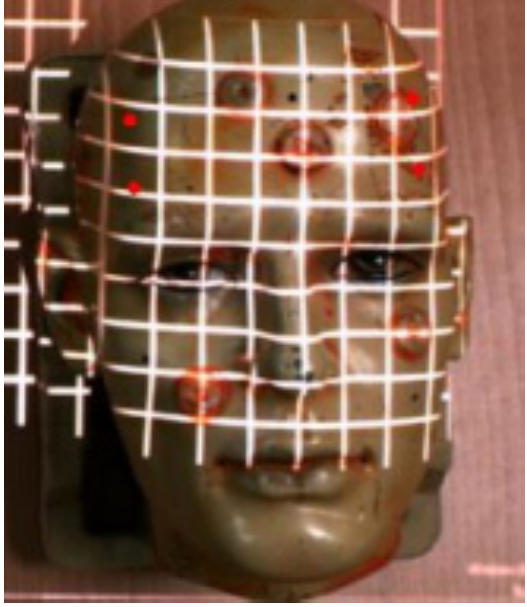
Figure 6. Project 2D scanlines onto a head phantom for calculating surface-based distortions.